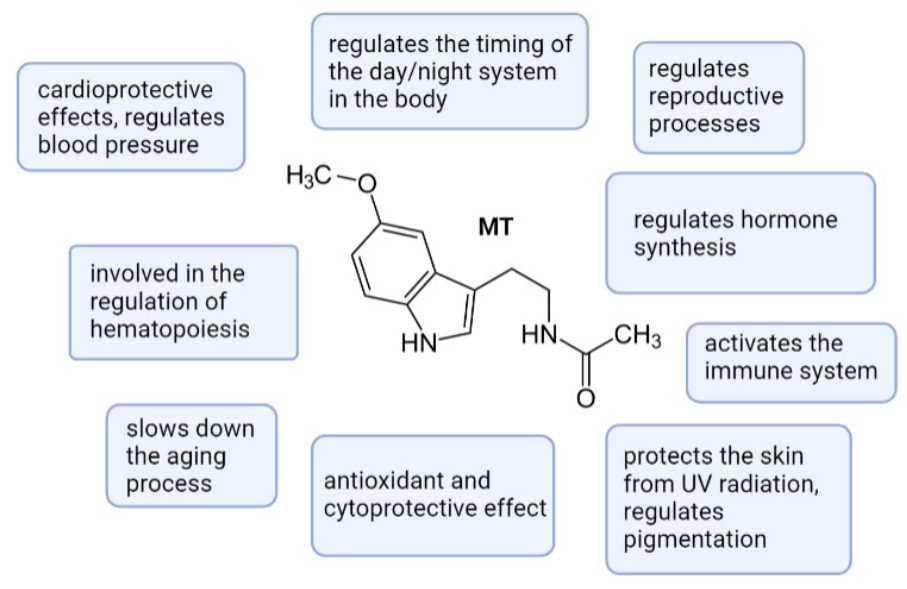
Figure 3. Diagram of the biological role of melatonin.